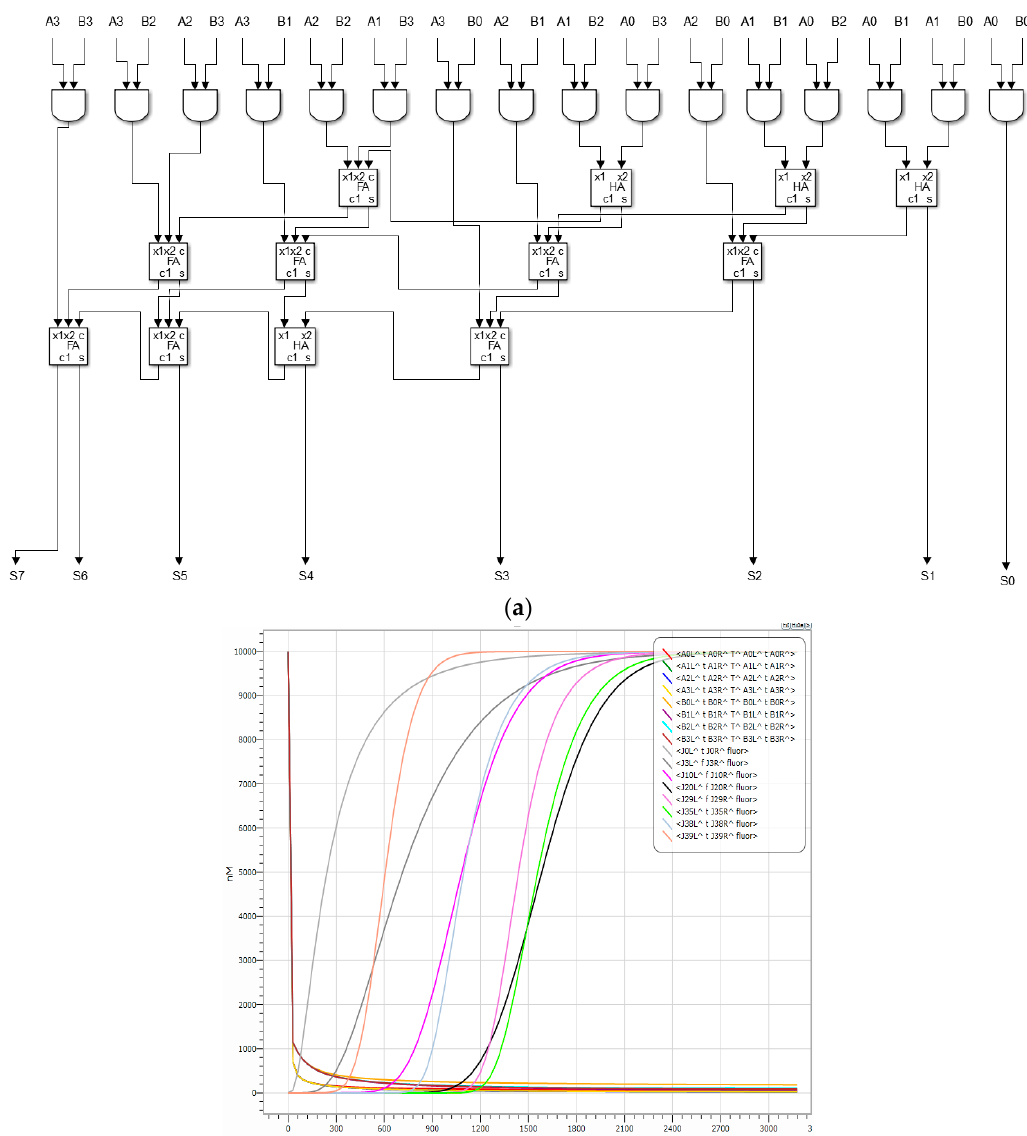
Figure 14. ( a ): Binary DNA 4 × 4 multiplier with a domain label; ( b ): Simulation of DNA 4 × 4 multiplier with a domain label.